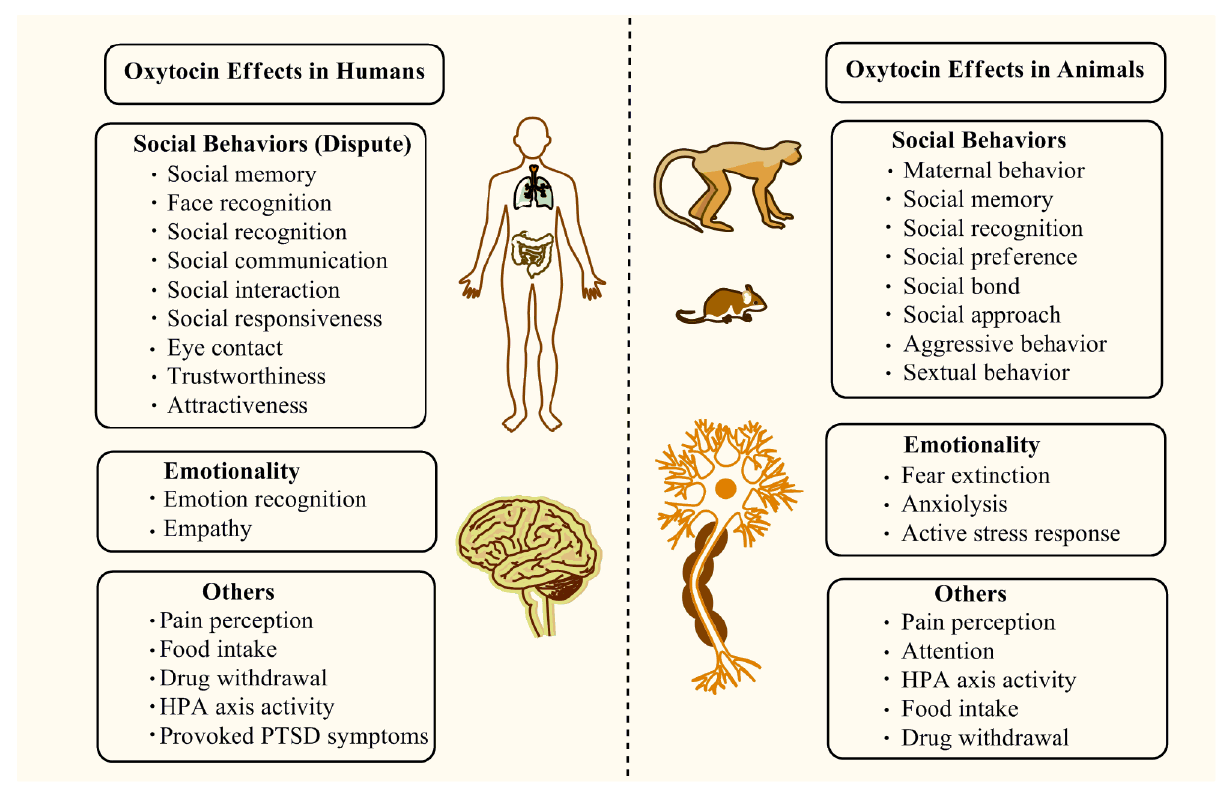
FIGURE3 The main regulatory effects of the OXT/OXTR system on social behaviors, emotionality, and other functions are found in humans and